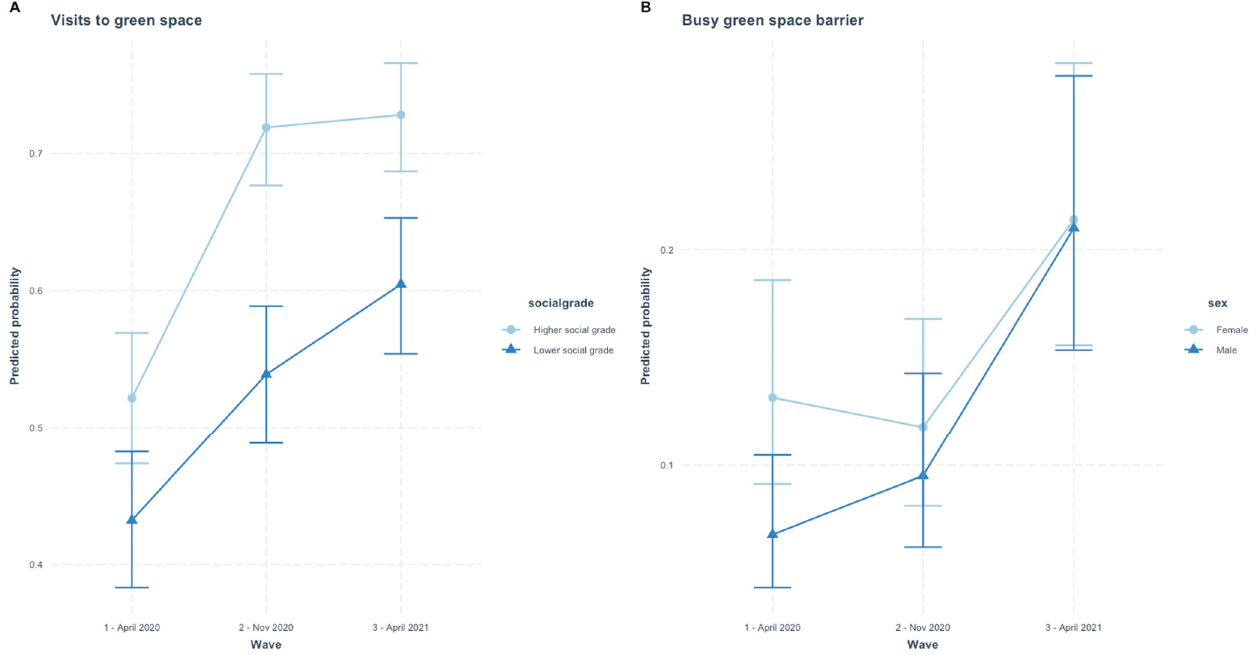
Figure 3. Predicted probability from logistic regression models with significant interaction for ( A ) visits to green space by wave and social grade and ( B ) the barrier ‘green spaces are too busy’ by wave and sex.